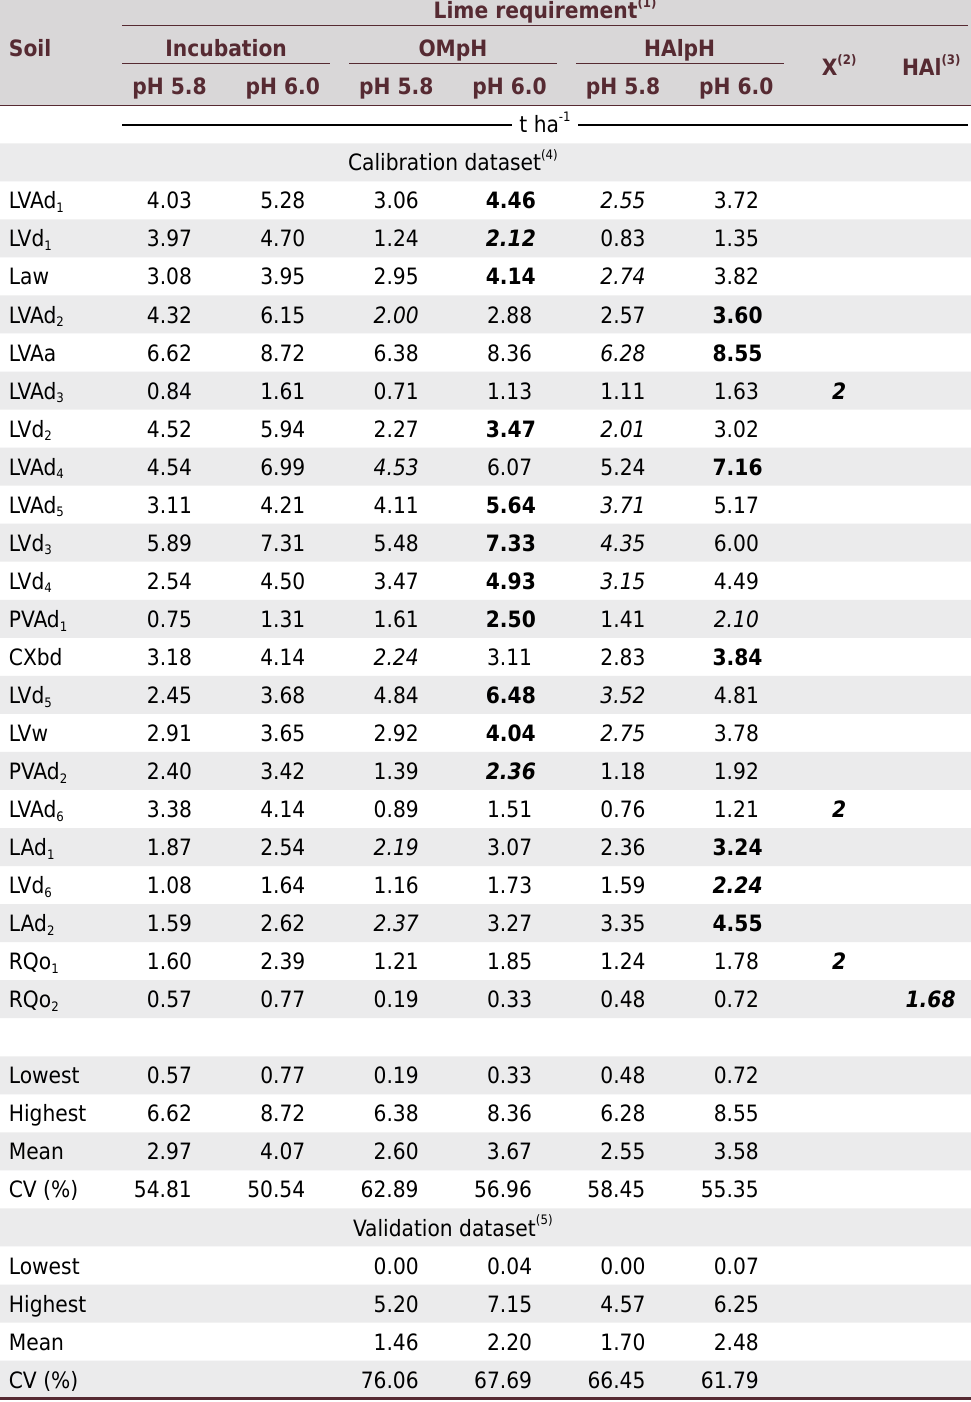
Table 3. Lime requirement estimated from the standard incubation method and from the new predictive models using organic matter (OMpH) and potential acidity (HAlpH) to attain pH 5.8 or 6.0 for the soils used to develop and validate the new predictive models Lime requirement Soil